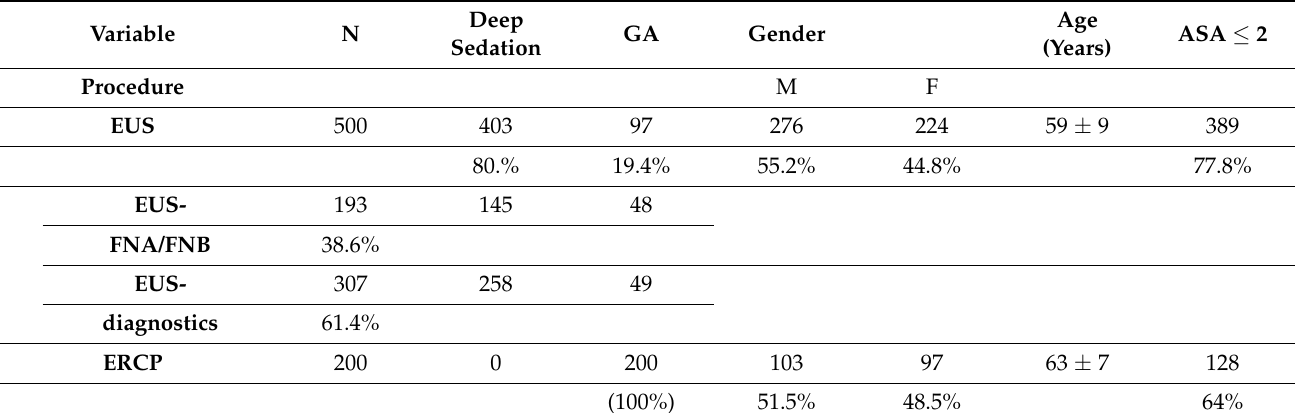
Table 2. Baseline patients’